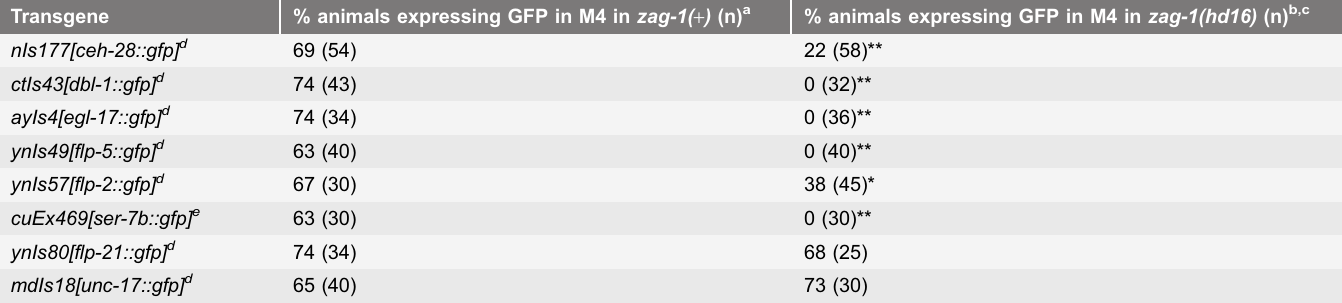
a GFP expression in the phenotypically wild-type + / + or zag-1(hd16)/ + progeny of zag-1(hd16)/ + hermaphrodites, which we refer to as zag-1( + ) . b GFP expression in the zag-1(hd16) homozygous progeny of zag-1(hd16)/ + hermaphrodites. c Statistically significant difference between zag-1(hd16) and zag-1( + ) . (*p , 0.02; **p , 0.0001). Calculated using the two-tailed, Fisher’s exact test. d Chromosomally integrated transgene is expected to be present in 75% of the progeny of transgenic hermaphrodites. e cuEx469 is an extrachromosomal transgene that is unlinked to any of the chromosomes. retained some expression in zag-1(hd16) mutants was flp-2::gfp , which was also